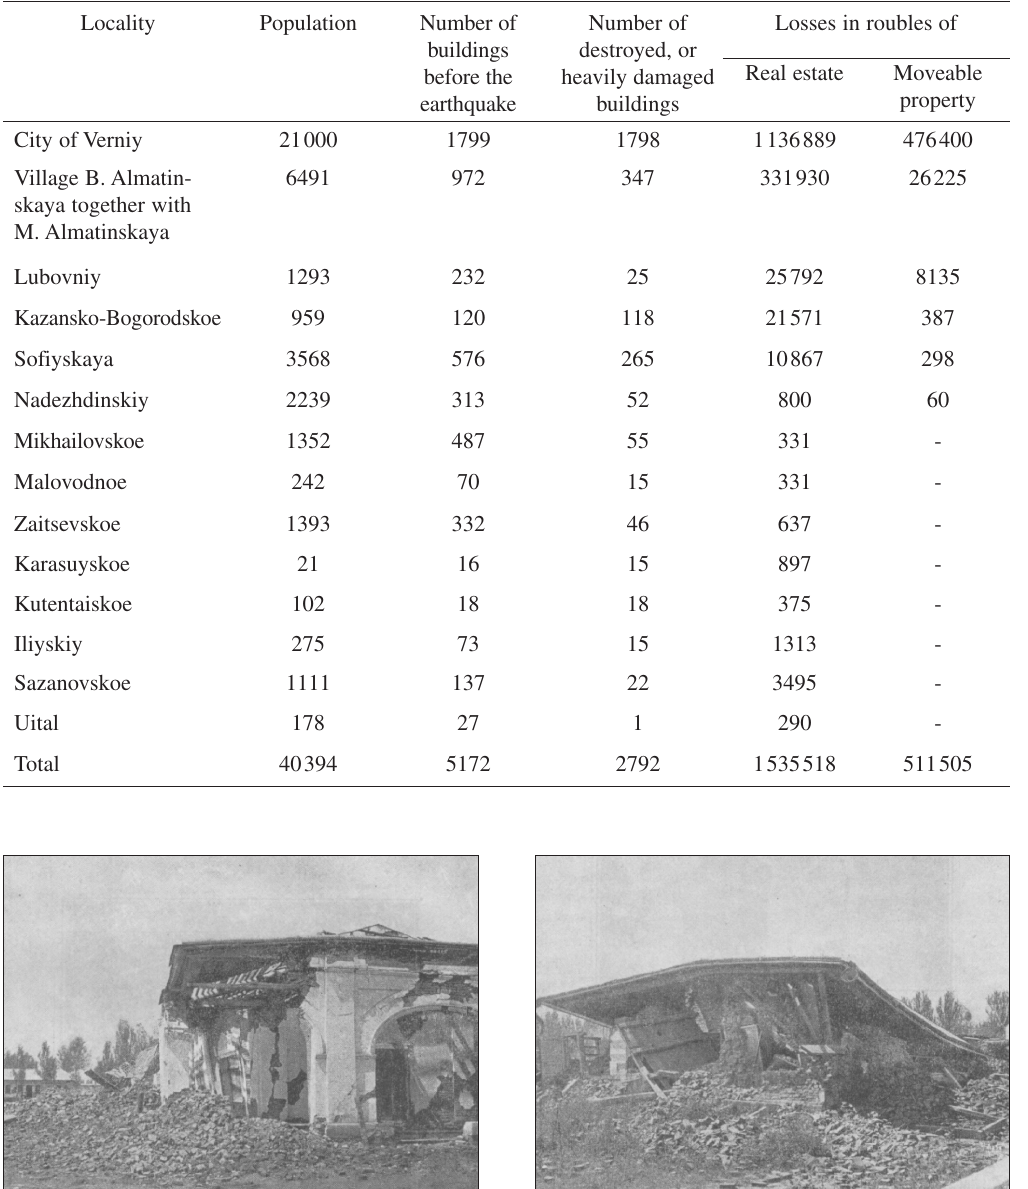
Fig. 2. Example of documentation of damage in Verniy (photos from Mushketov, 1890). We can clearly see the type of construction and